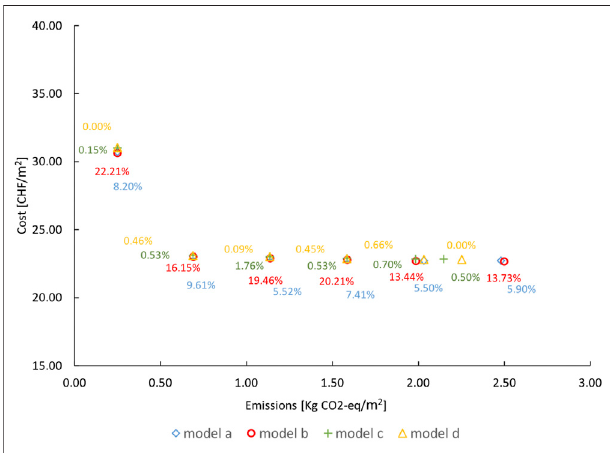
FIGURE 17 | Pareto points of optimization model (A) - (D) with the percentage of insuf fi cient temperature supply indicated.